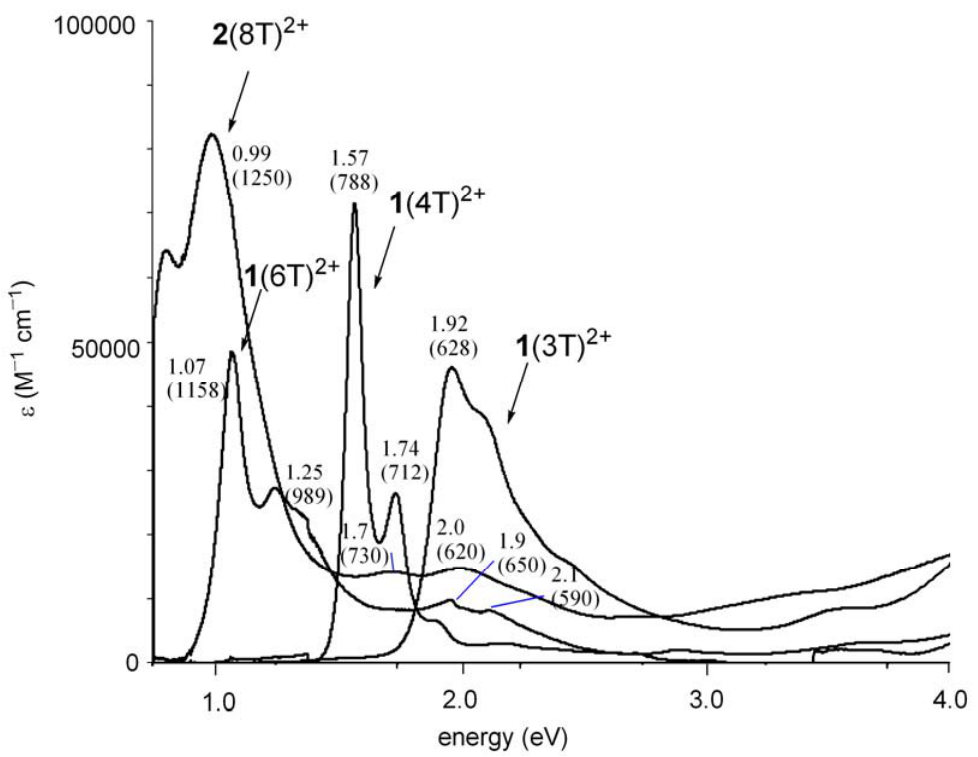
Figure 5. UV-vis-NIR spectra of 1 (nT) 2+ (n = 3, 4, 6) and 2 (8T) 2+ . The numbers in parentheses are the absorptions in wavelength scale